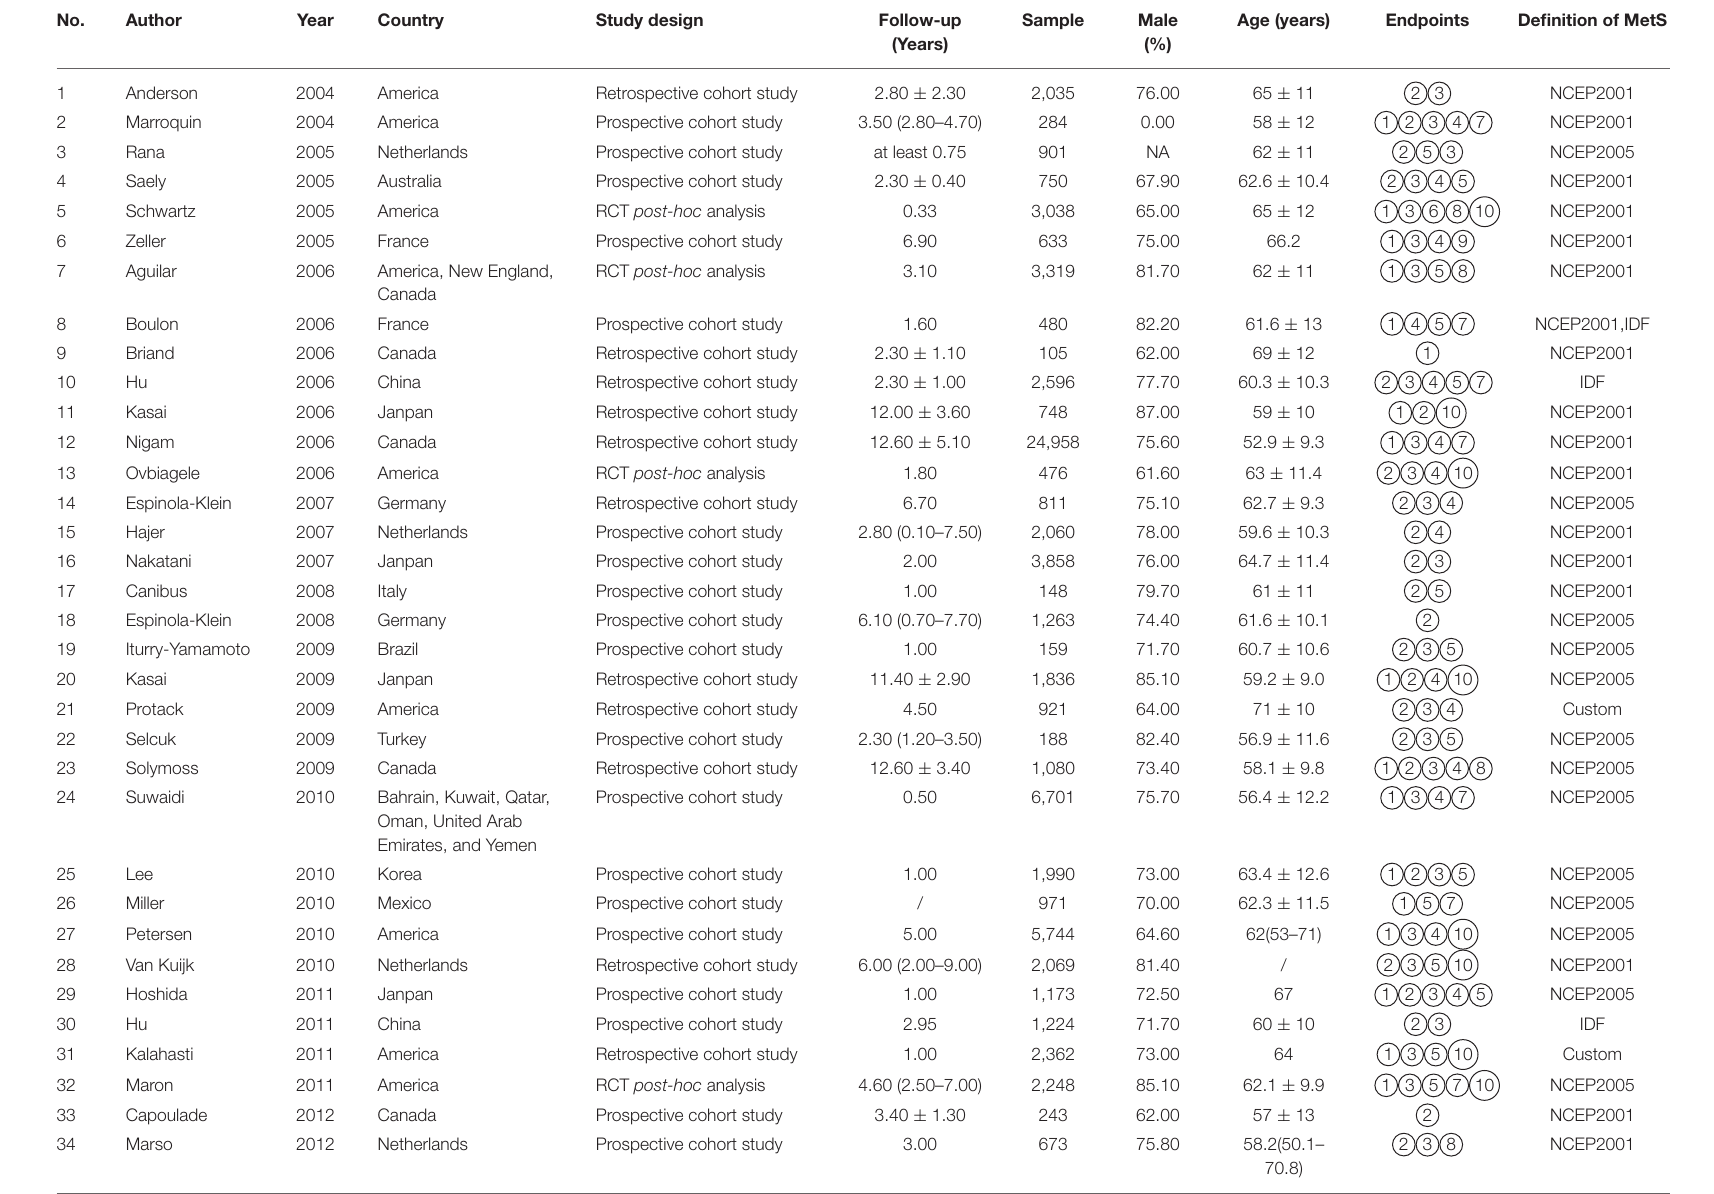
TABLE 1 | Characteristics of included